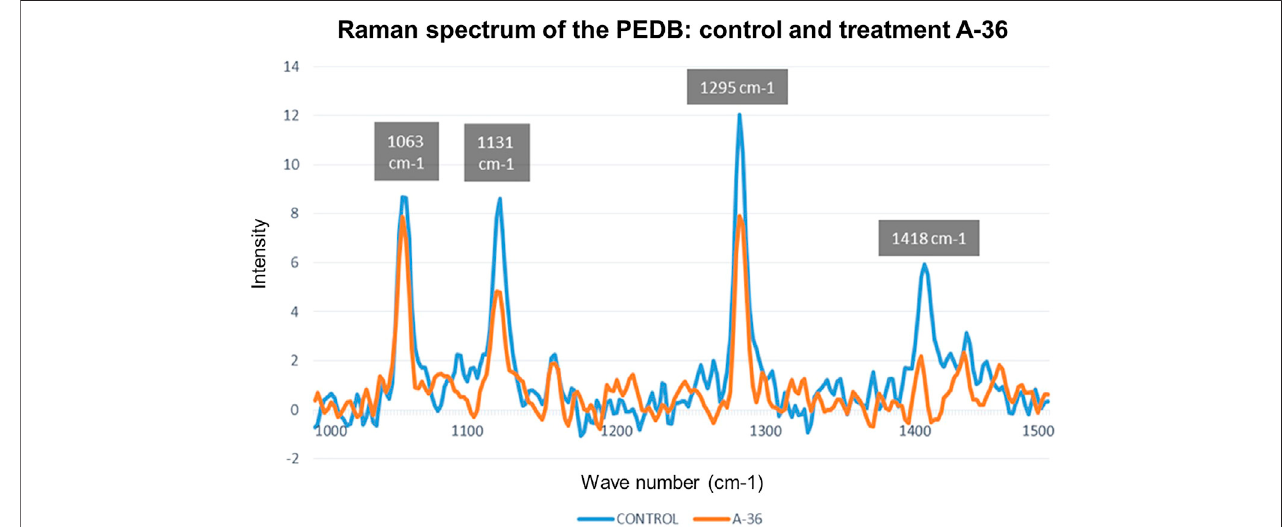
FIGURE 6 | Raman spectrum to contrast the difference between the LDPE control and the treatment A-36 h.